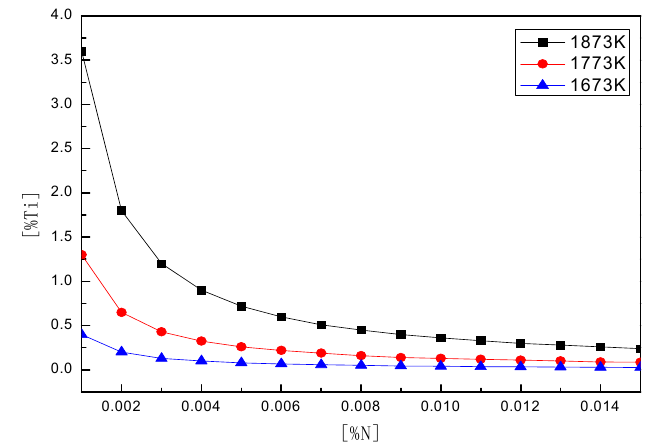
Figure 11. [Ti] and [N]-balanced concentrations in molten steel under different temperatures.